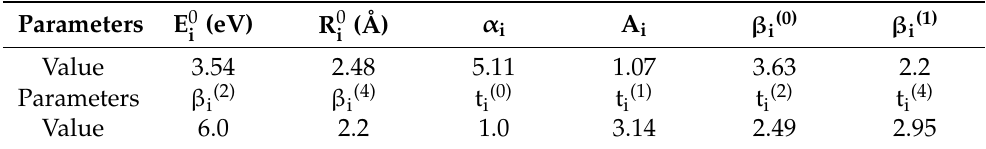
Table 1. Parameters of the cubic Cu material model